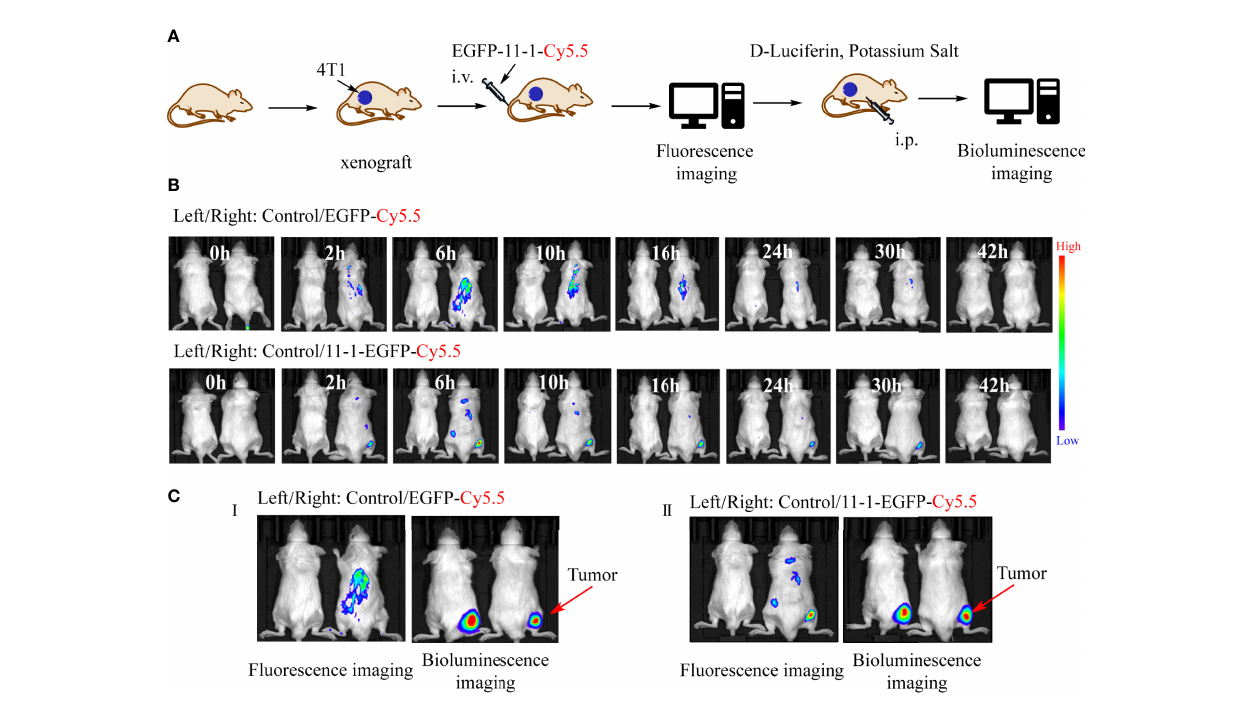
FIGURE 4 | The tumor-targeting effects of anti-CD147 nanobody in vivo assays. (A) The scheme of tumor targeting of 11-1 nanobody. (B) The fl uorescent images were observed in tumor at 0, 2, 6, 10, 16, 24, 30, and 42 h post-injection of PBS, EGFP-Cy5.5, and EGFP-11-1-Cy5.5, respectively. (C) The bioluminescence images were observed in tumor at 6 h post-injection of PBS, EGFP-Cy5.5, and EGFP-11-1-Cy5.5,